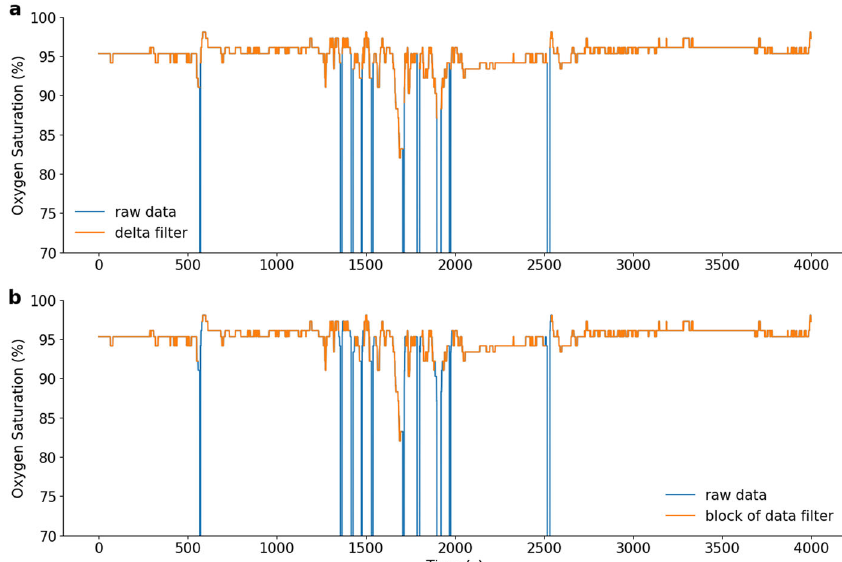
Fig. 4 Example of preprocessing approaches. a shows the time series preprocessed with the delta fi lter technique, and b shows the same time series preprocessed with the block of data